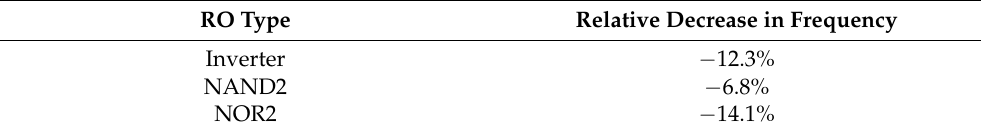
Table 4. RO frequency differences from 0 krad(Si) of exposure to 1000 krad(Si) during Co-60